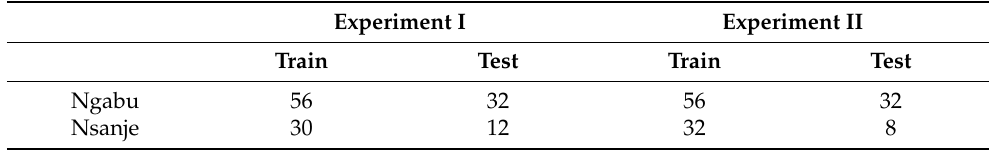
Table 5. Sample sizes for the train and test set to split for each experiment and